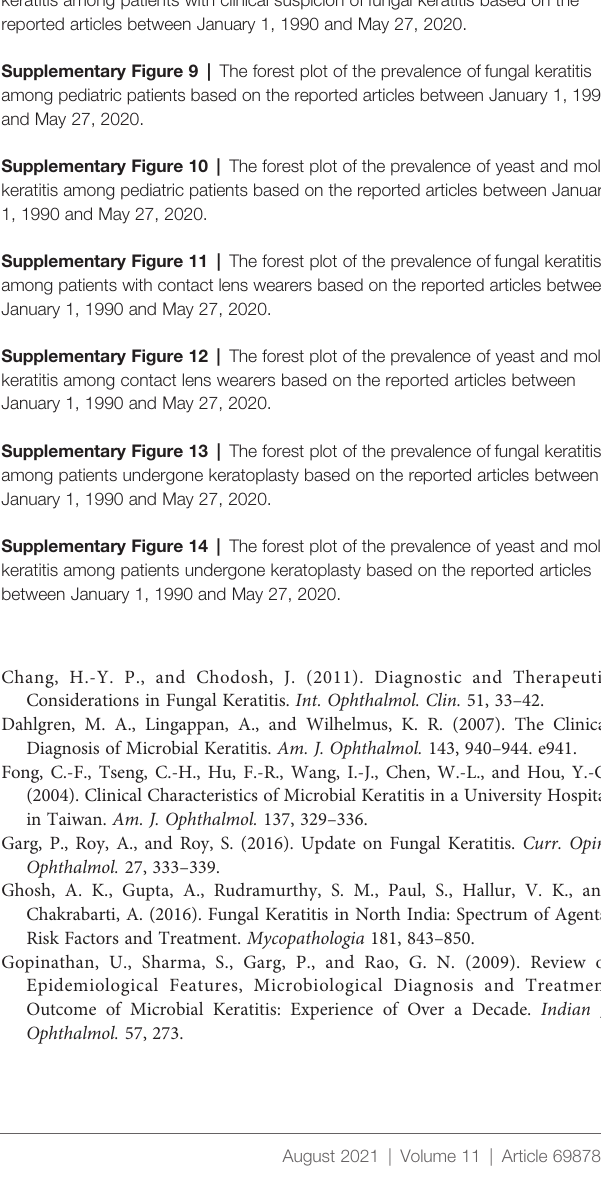
Supplementary Figure 6 | The forest plot of the prevalence of yeast and mold keratitis among patients with culture-con fi rmed microbial keratitis based on the reported articles between January 1, 1990 and May 27, 2020. Supplementary Figure 7 | The forest plot of the prevalence of fungal keratitis among patients with clinical suspicion of fungal keratitis based on the reported articles between January 1, 1990 and May 27, 2020. Supplementary Figure 8 | The forest plot of the prevalence of yeast and mold keratitis among patients with clinical suspicion of fungal keratitis based on the reported articles between January 1, 1990 and May 27, 2020. Supplementary Figure 9 | The forest plot of the prevalence of fungal keratitis among pediatric patients based on the reported articles between January 1, 1990